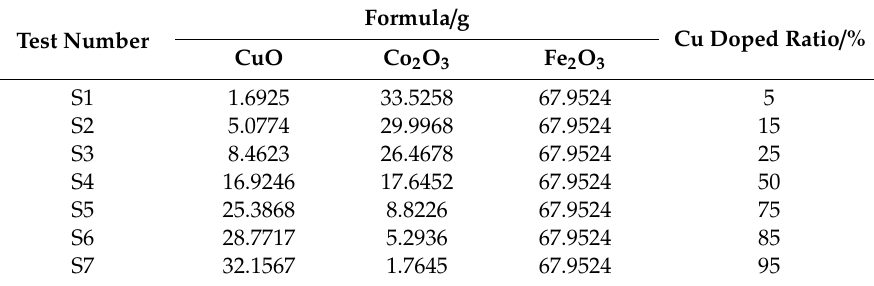
Table 1. Formula for Cu x Co 1 − x Fe 2 O 4 solid solution.